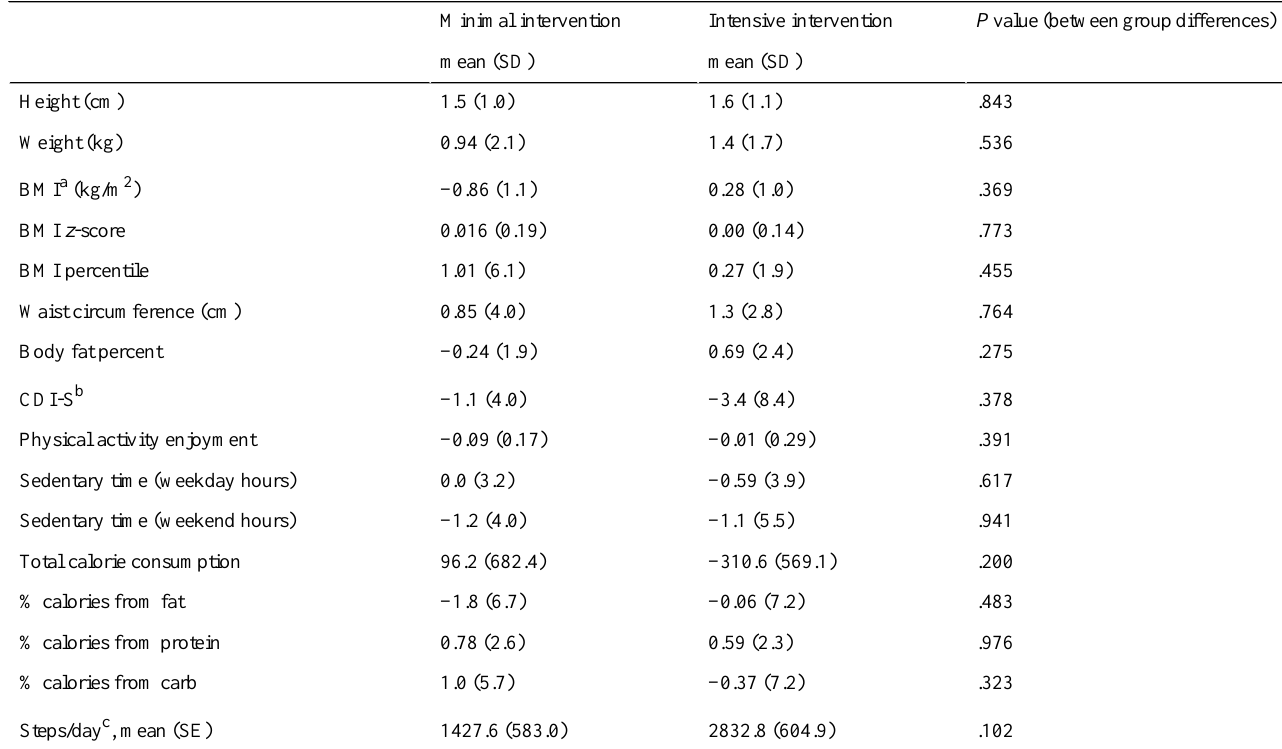
Table 4. Change in outcome variables from baseline to 12 weeks.